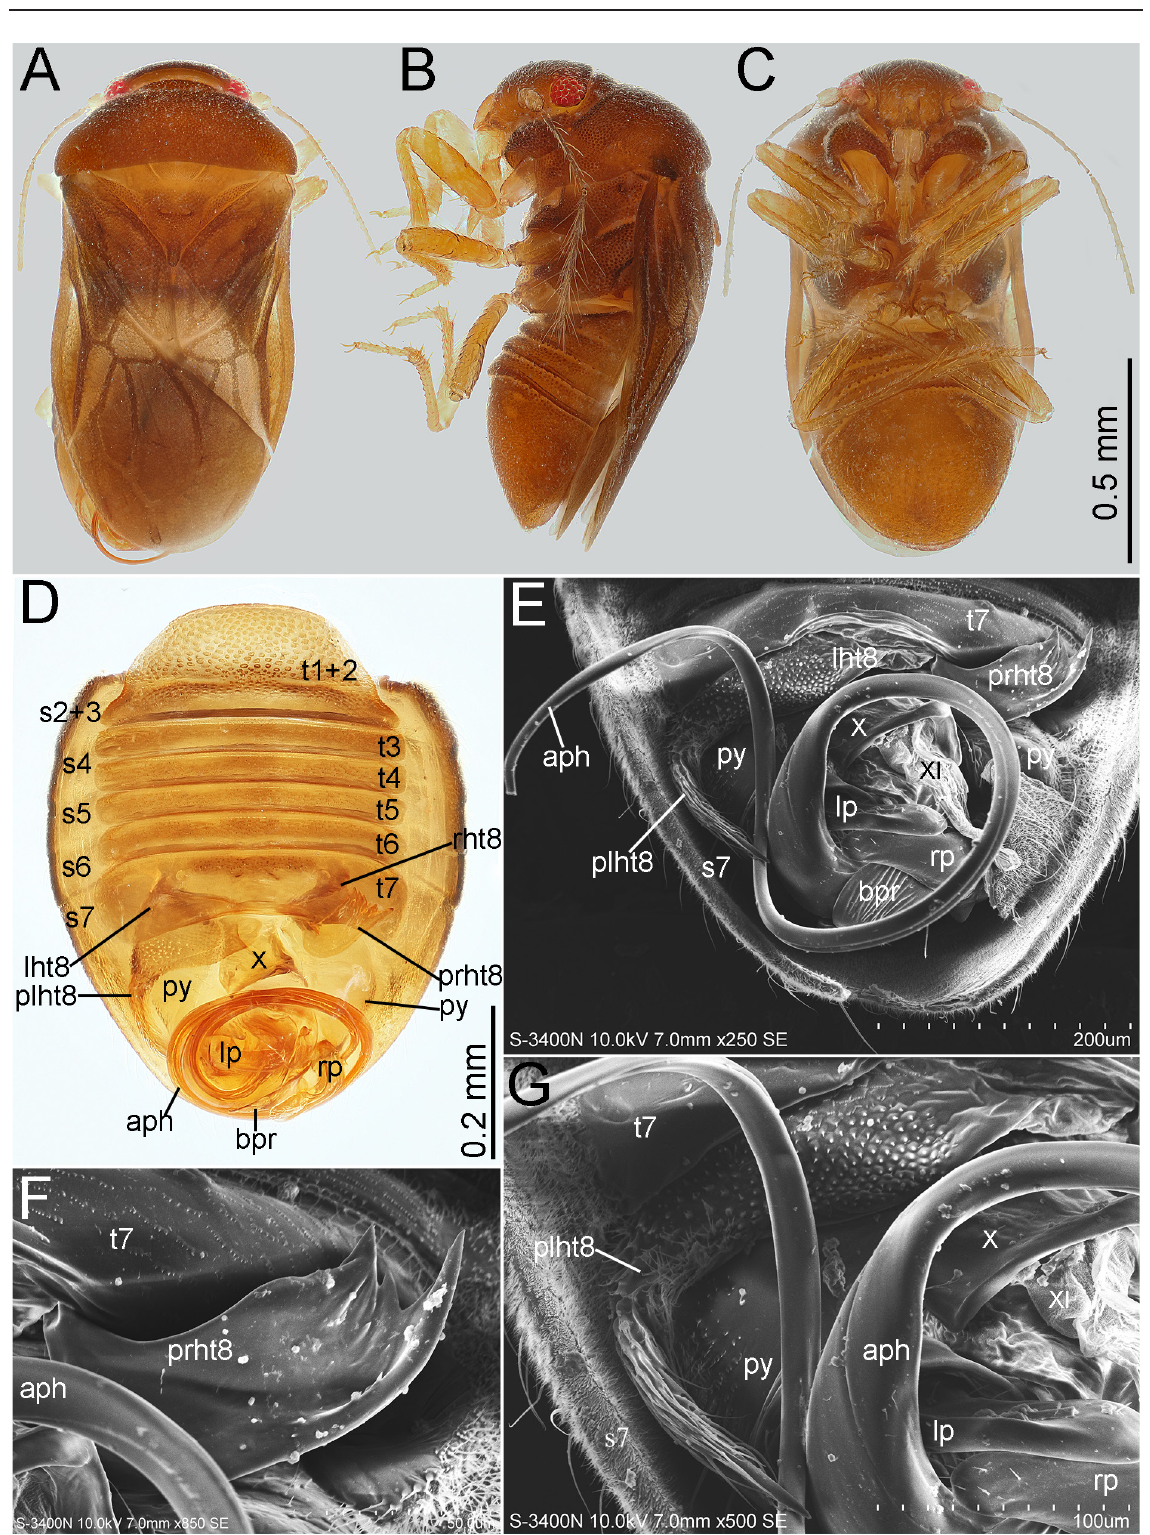
Fig. 3. Kokeshia baii sp. nov. A‒C . Habitus, holotype, ♂ (SYSBM). A . Dorsal view. B . Lateral view. C . Ventral view. D . Pregenital abdomen and genitalia, dorsal view, paratype, ♂ (SYSBM). E‒G . Scanning electron micrographs of genitalia, paratype, ♂ (SYSBM). E . Dorsal view. F . Right side, dorsal view. G . Left side, dorsal view. Abbreviations: see Material and